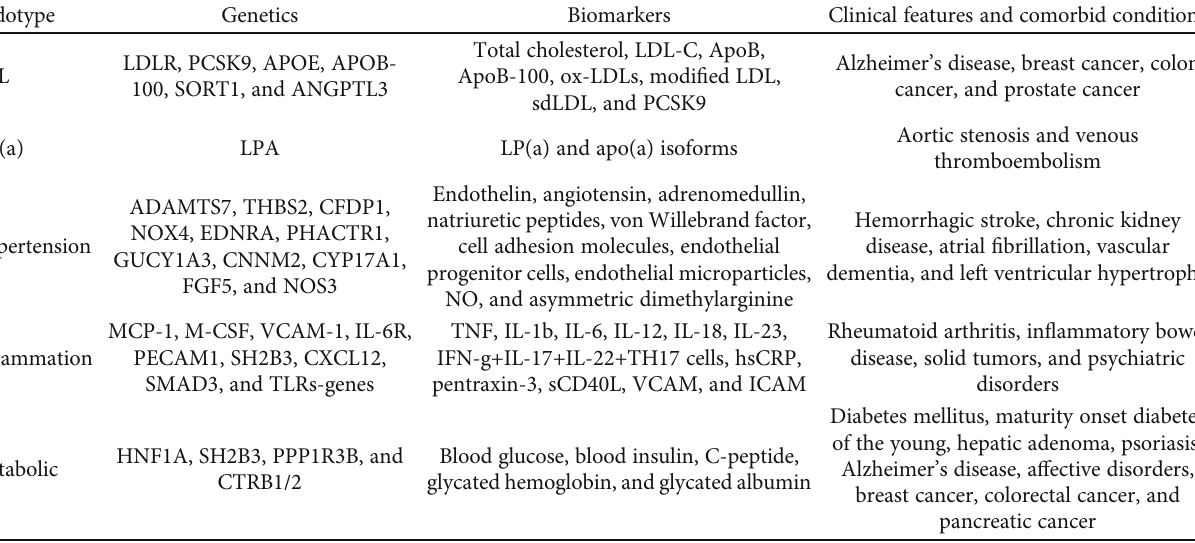
Table 1: Summary of the main endotypes of atherosclerosis [36, 37, 42, 61, 62, 70, 84, 93, 99 –